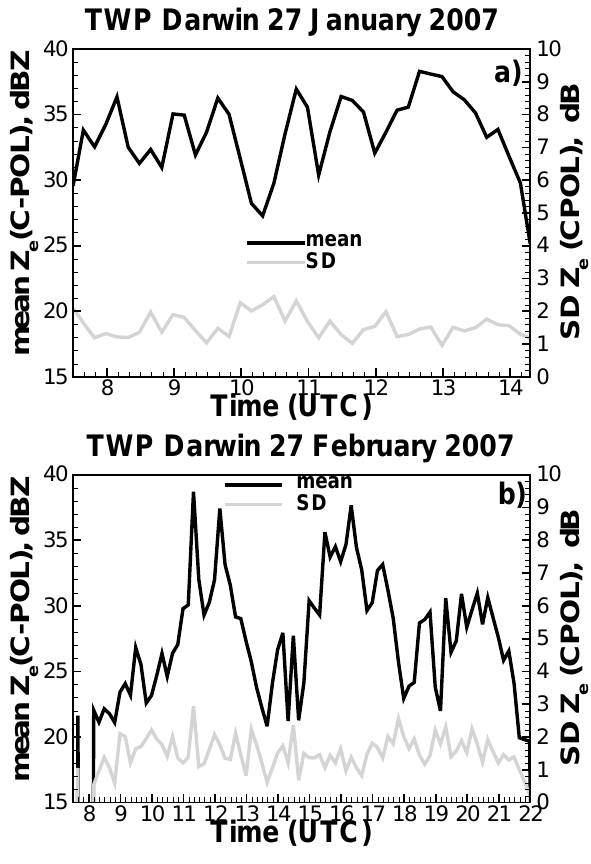
Fig. 3. Time series of mean and standard deviation values of C- POL reflectivity vertical profiles in the rain layer for the events of 27 January 2007 (a) and 27 February 2007 (b) .